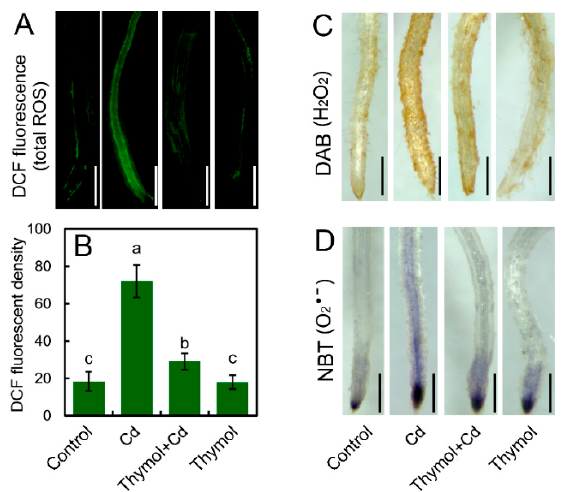
Figure 2. The effect of thymol on ROS generation in the roots of tobacco seedlings under Cd stress. The roots of seedlings were treated with water (control), CdCl 2 (20 μ M), CdCl 2 (20 μ M) + thymol (100 μ M), and thymol (100 μ M) for 72 h. ( A ) The roots were loaded with DCFH-DA for the observation of total ROS fluorescence with a fluorescent microscope; ( B ) The DCF fluorescent density was quantified to indicate the relative total ROS level in roots; ( C ) The roots were stained with DAB to indicate H 2 O 2 content; ( D ) The roots were stained with NBT to indicate O 2• ¯ content. Bar = 1 mm. Different letters in ( B ) indicated that the mean values of three replicates are significantly different between the treatments ( p < 0.05, ANOVA, LSD).